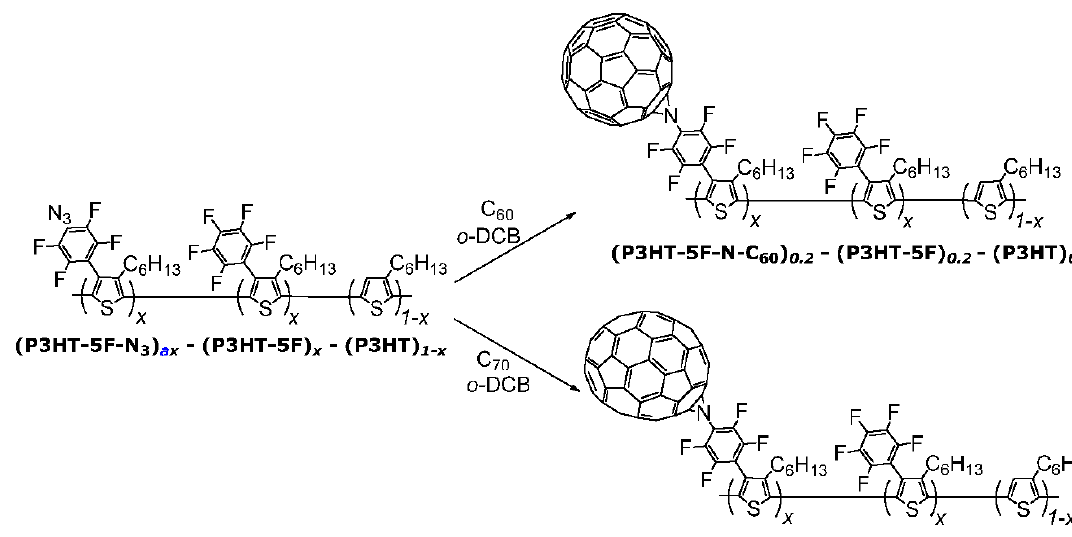
Scheme 3. Synthetic procedure of side -[P3HT 0.6 -(P3HT-5F) 0.4 ] hybrids with C 60 or C 70 fullerenes.